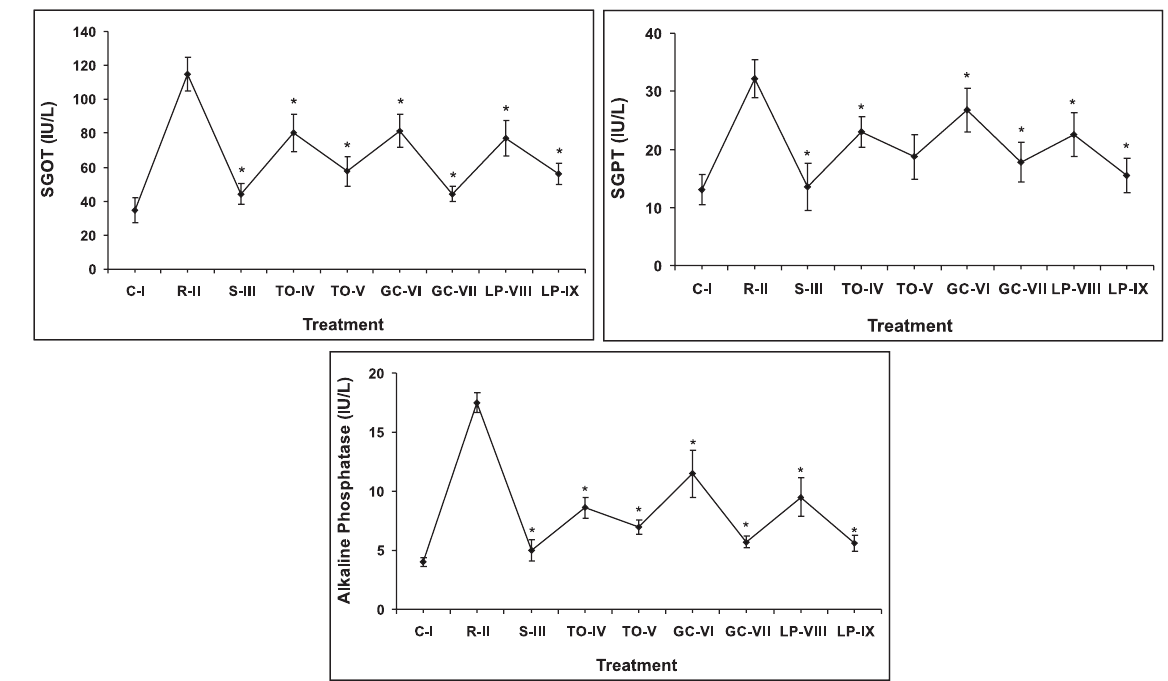
FIGURE 3 - Hepatoprotective activity of seaweed Turbinaria ornata , Gracilaria crassa and Laurencia papillosa acetone extracts: SGOT, SGPT and alkaline phosphatase. (Values: mean±SD of four replicates; *P<0.05 compared to Rifampicin group; C-Control; R-Rifampicin-1000 mg/kg; S-Silymarin-100 mg/kg; TO- Turbinaria ornata ; GC- Gracilaria crassa ; LP- Laurencia papillosa ;